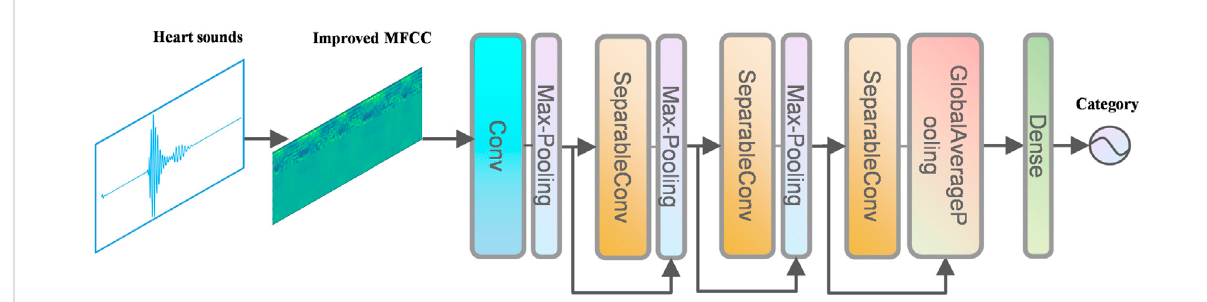
FIGURE 6 Structure of Resnet.